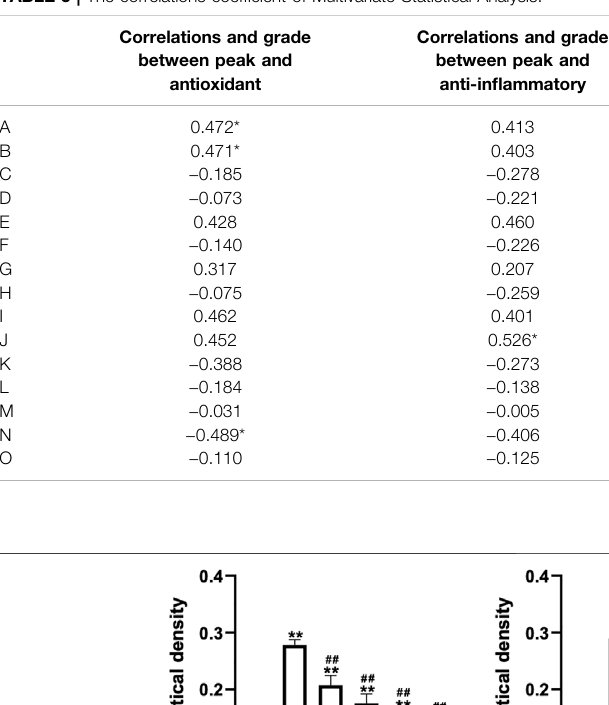
TABLE 5 | The correlations coef fi cient of Multivariate Statistical Analysis.